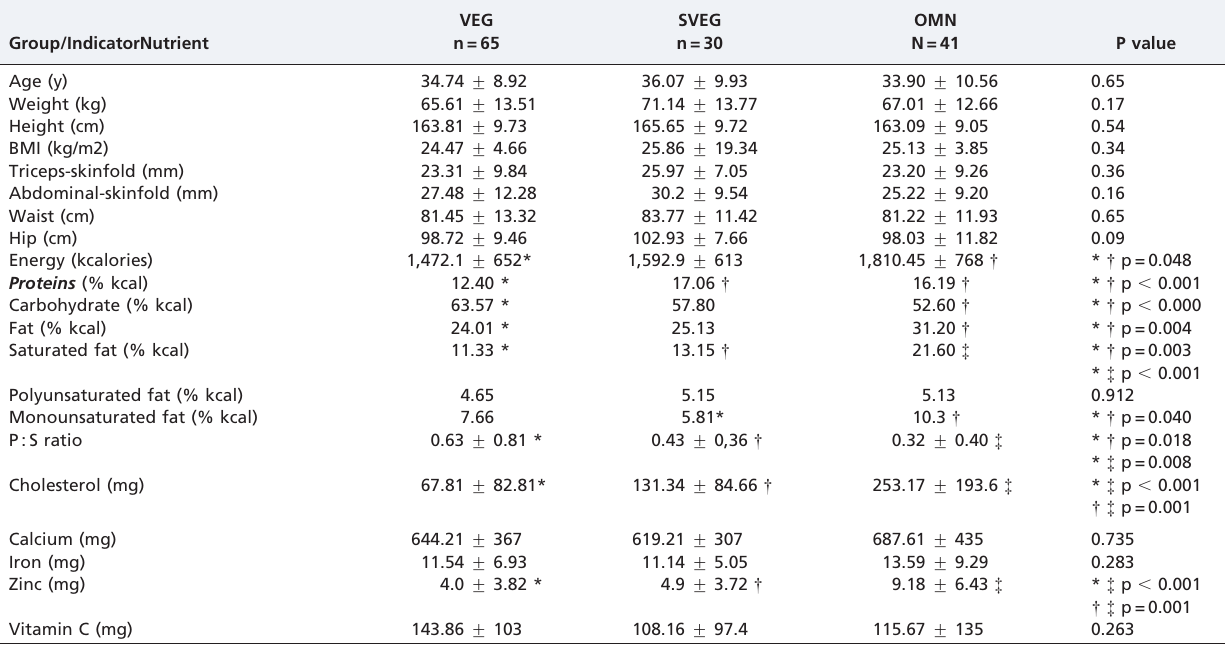
Table 1 - Distribution of anthropometric indicators and nutrient